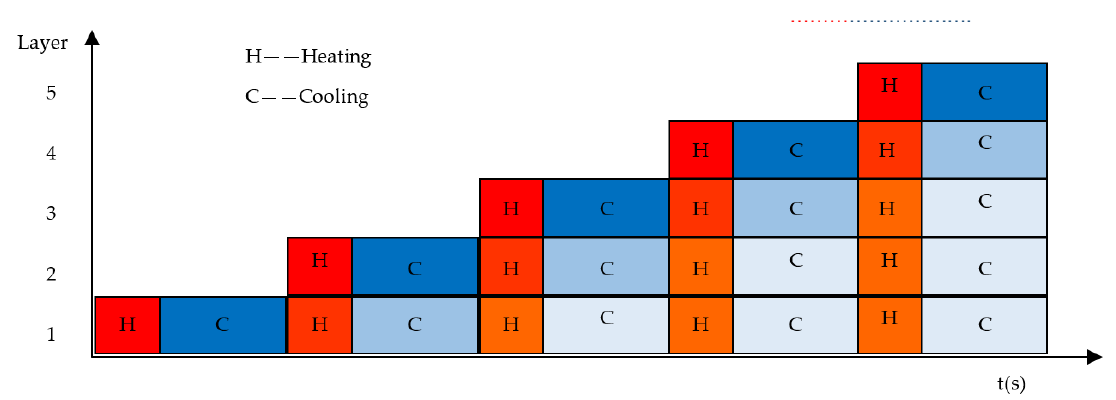
Figure 13. The time component diagram of the part of layer and its corresponding thermal superposition effect diagram from the simulation. The red color is the heating time of SLM sample in simulation, the blue color is cooling time. In addition, the darker the color, the higher the temperature gradient.